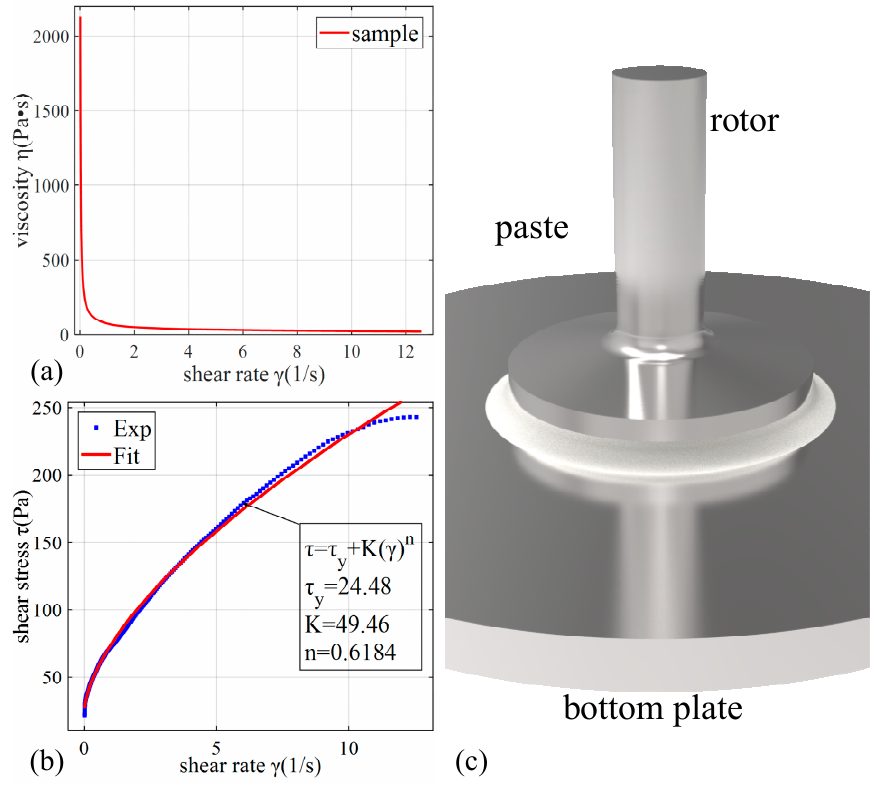
Figure A1. ( a ) Relationship between the apparent viscosity of the conductive paste and the shear rate. ( b ) Shear stress and shear rate fitting results. ( c ) Sketch of the rheometer measurement process.